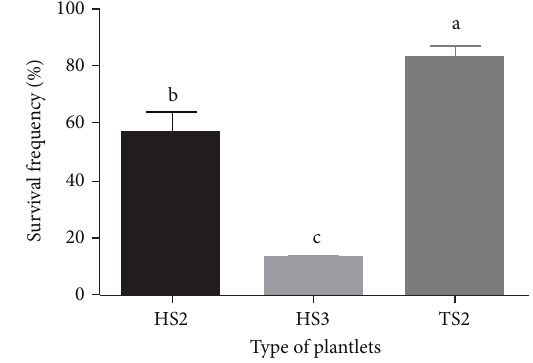
Figure 4: Survival frequency of HS2, HS3, and TS2 plantlet after ex vitro transplantation for 6 months. Values with different letters in a column are significantly different according to Duncan’s multiple range test at the 5% level.